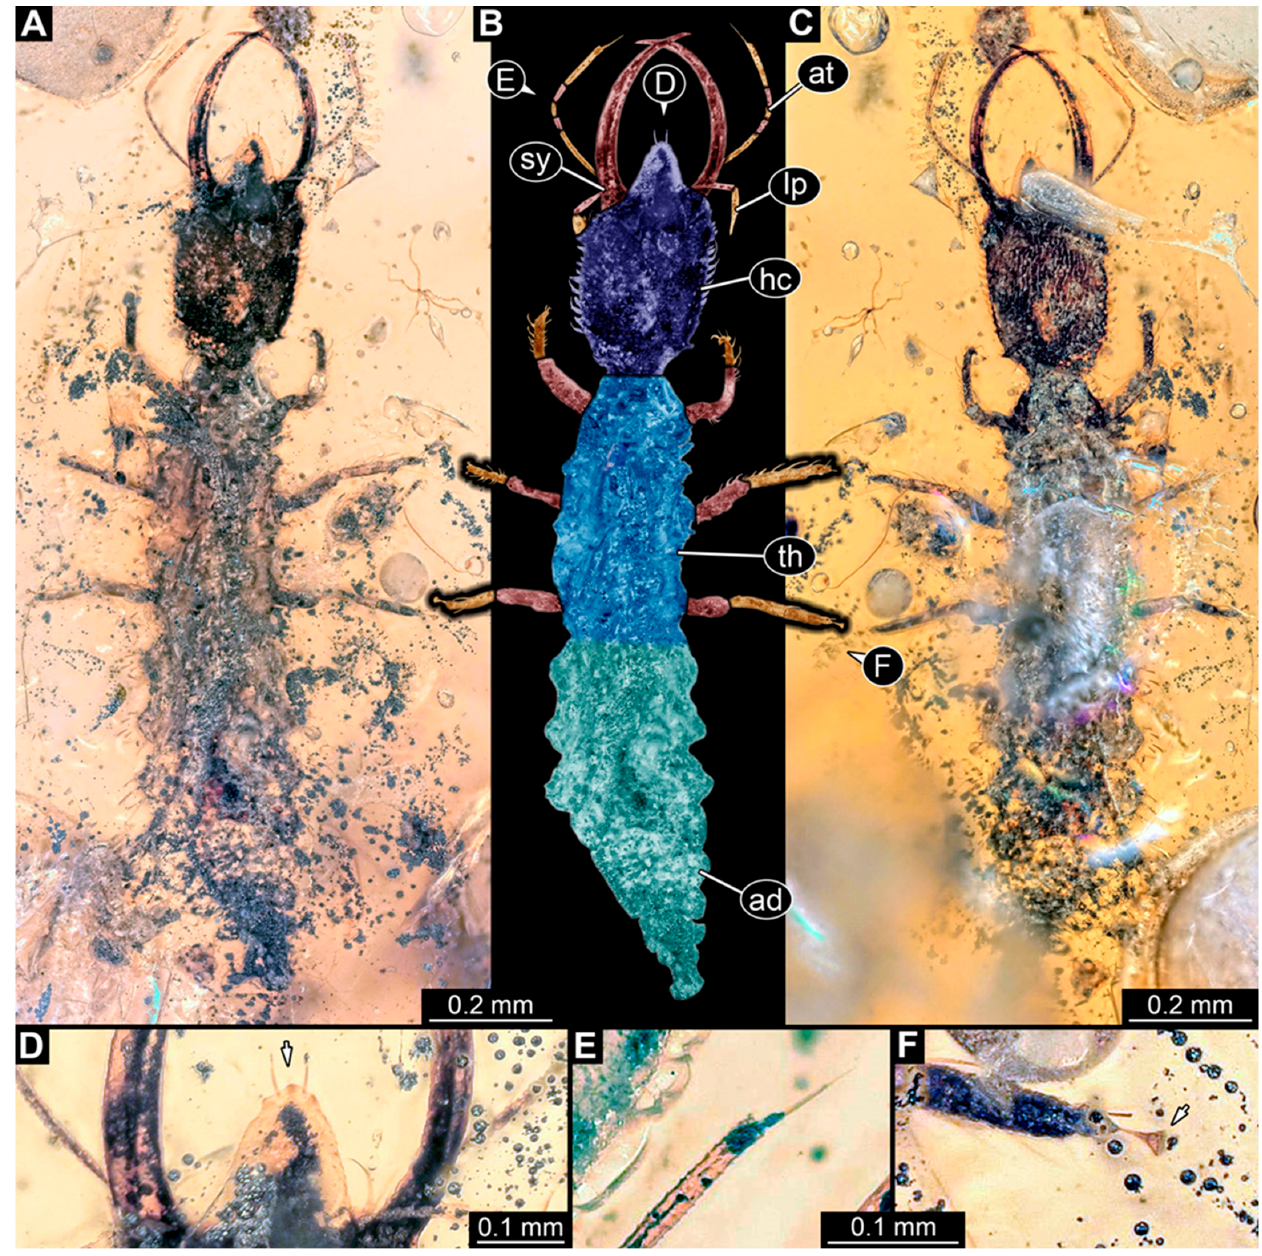
Figure 26. Specimen 91 (PED 2309); Myanmar amber. ( A ) Ventral view. ( B ) Ventral view, colour- marked. ( C ) Dorsal view. ( D ) Close-up of labrum; arrow marks labrum. ( E ) Close-up of antenna. ( F ) Close-up of third locomotory appendage; arrow marks empodium. Abbreviations: ad = abdomen; at = antenna; hc = head capsule; lp = labial palp; sy = stylet; th = thorax. (40) Specimen 92 (PED 2311) is preserved in Cretaceous amber from Myanmar (Figure 27). The specimen is well accessible in the dorsal (Figure 27A,B) and ventral views (Figure 27C), but is partly concealed by Verlumung and dirt particles in the dorsal and ventral views. The labrum is prominent, being triangular symmetric to trapezium-like and very elongated. The specimen has an approximate length of 1.3 mm.